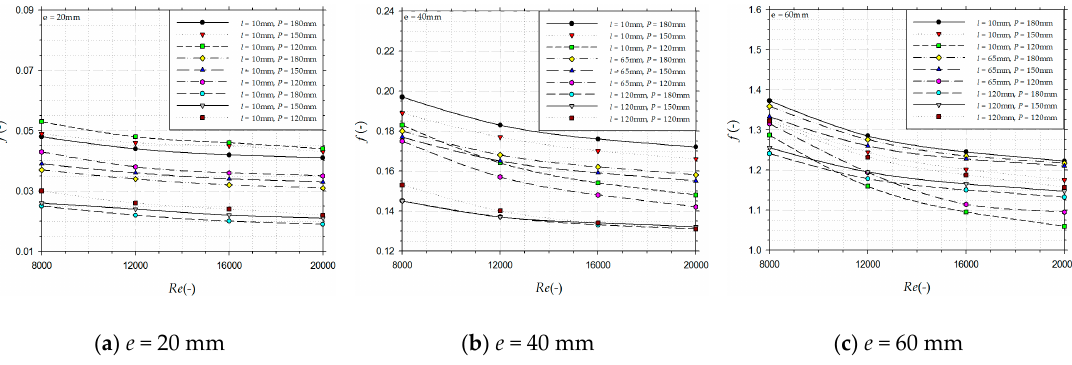
Figure 10. Friction factor for different value of pitch ( P ), length ( l ), and for a fixed value of height ( e ) with Reynolds number.